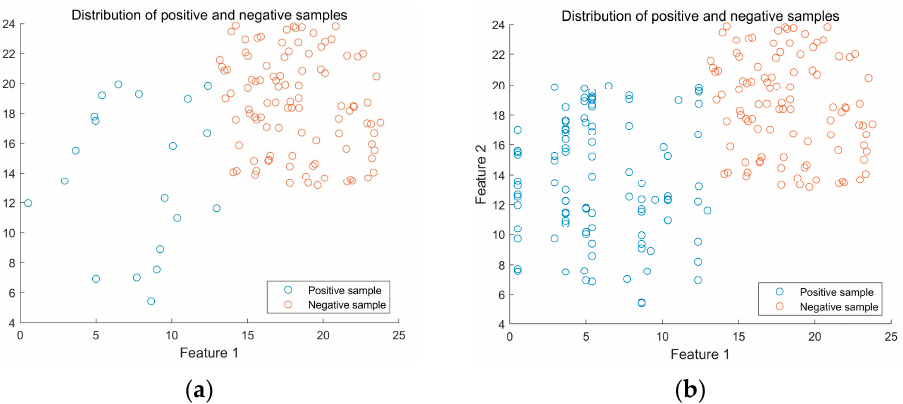
Figure 5. ( a ) Comparison of echocardiogram dataset before applying SMOTE algorithm; ( b ) comparison of echocardiogram dataset after applying SMOTE algorithm.